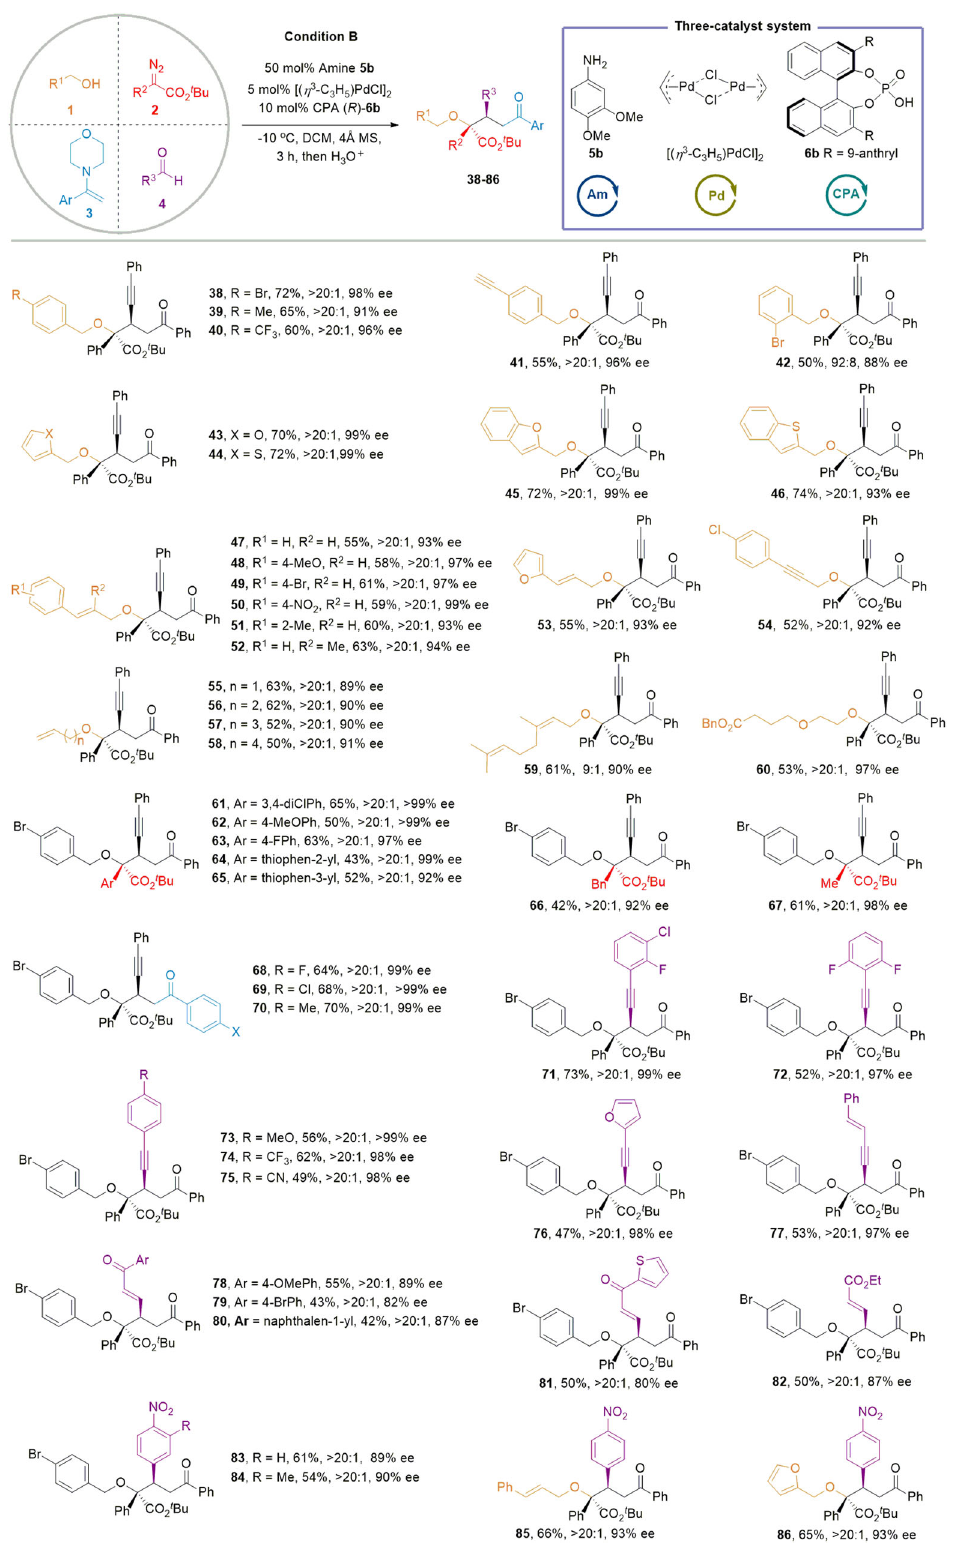
Fig. 3 | Substrate scope of enantioselective four-component reactions of alcohol, diazoester, enamine and aldehyde derivatives. Standard condition: 1 / 2 / 3 / 4/5b /[PdCl(allyl)] 2 / 6b =0.18/0.18/0.18/0.15/0.075/0.0075/0.015mmol, 2 and